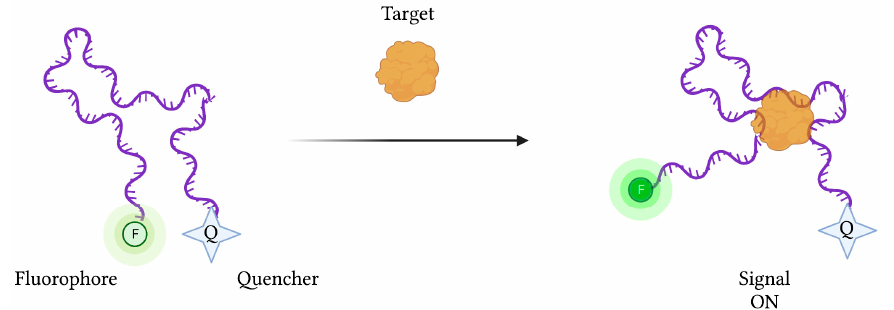
Figure 4. The schematic illustration of a generic “signal-on” Fluorescence-based aptasensor. Biorecog- nition of the target analyte by the aptamer induces a change in conformation, resulting in a displace- ment of the fluorophore away from the quencher, resulting in fluorescence emission. Created with BioRender.com (accessed on 19 December 2021).